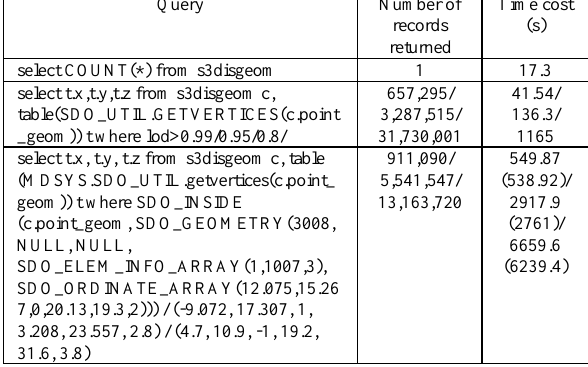
Table 3. Query performance on S3DISGEOM.